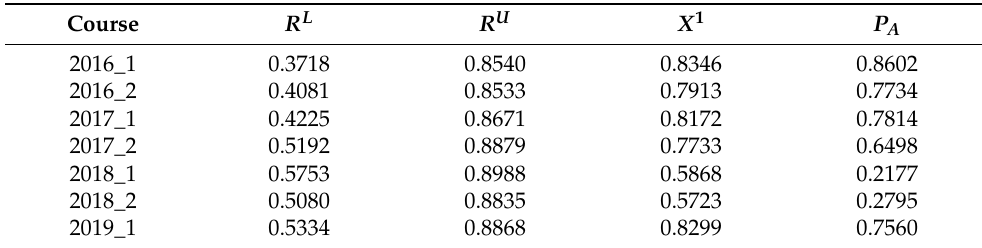
Table 3. Average of the a priori, posteriori and academic performance indicator results by semester.